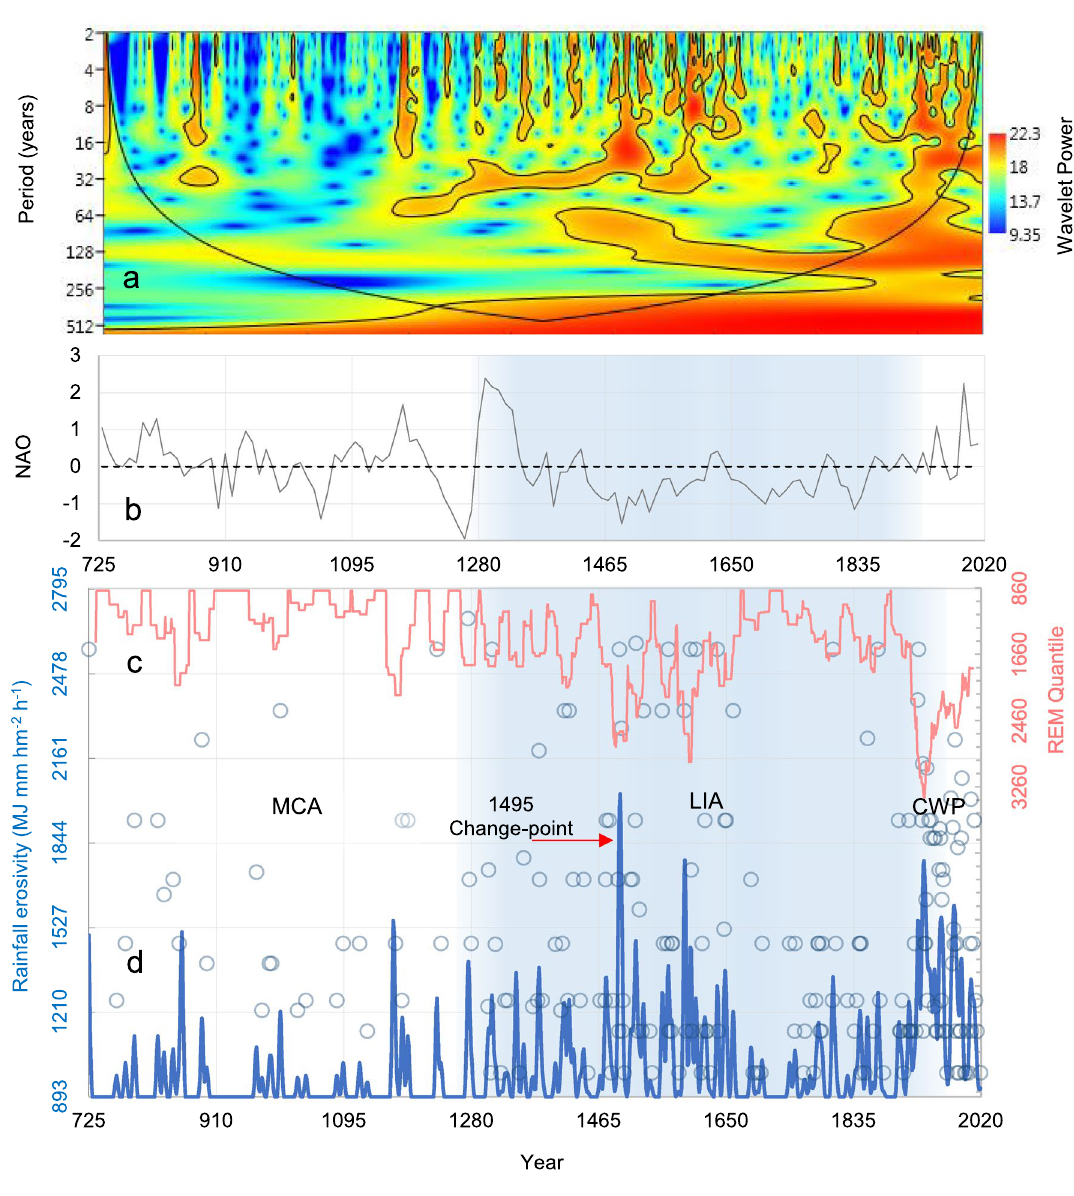
Figure 5. Rainfall erosivity and climatic patterns over the 725–2019 CE period in the Tiber River Basin. ( a ) Wavelet spectrum of the rainfall erosivity time-series with bounded colours identifying 0.05 significance areas (the bell-shaped, black contour marks the limit between the reliable region and the region below the contour where the edge effects occur, a.k.a. cone of influence ( b ) North Atlantic Oscillation (annual NAO from Hernández et al. 100 ); ( c) Trend of quantile-rainfall erosivity with return period T = 50 years (red curve); ( d) Evolution (red arrow indicating the change-point year 1495) of estimated annual rainfall erosivity (blue circles) with the relative smoothed trend by the 11-year Gaussian function (bold blue curve). The y -right axes in ( c ) is in the reverse-scale. MCA: Medieval Climate Anomaly (725–1249 CE); LIA: Little Ice Age (1250–1849 CE); CWP: Current Warm Period (1850–2019 CE). The LIA is identified as a light blue area across the graphs ( b – d